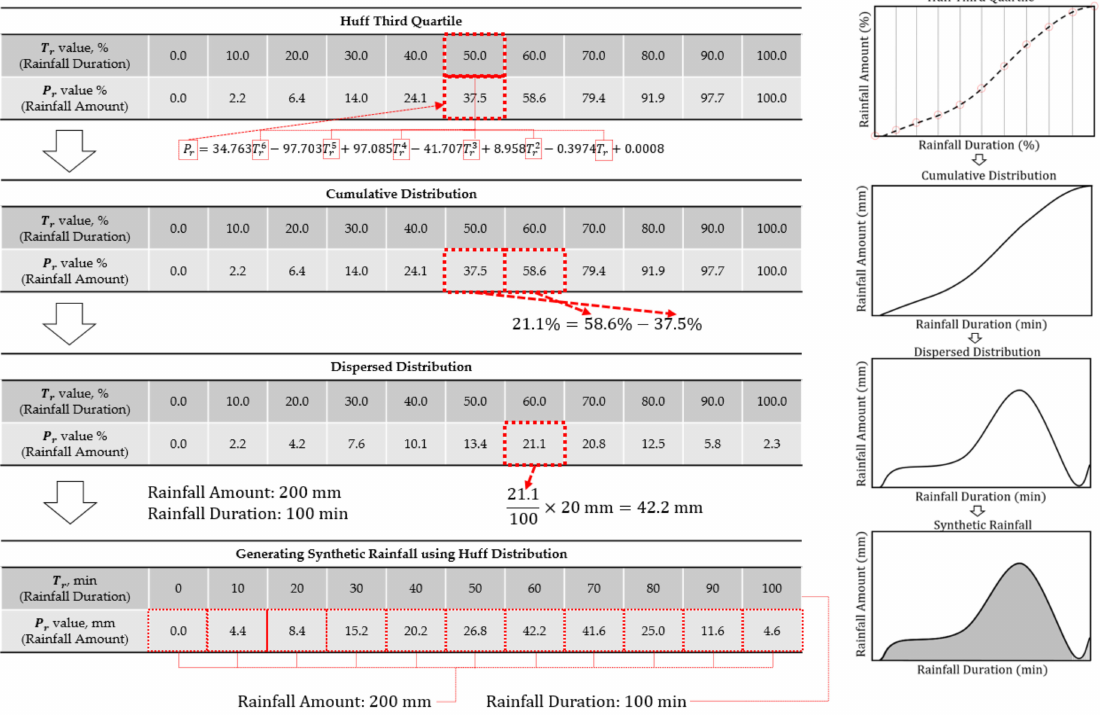
Figure 1. Synthetic rainfall data generation